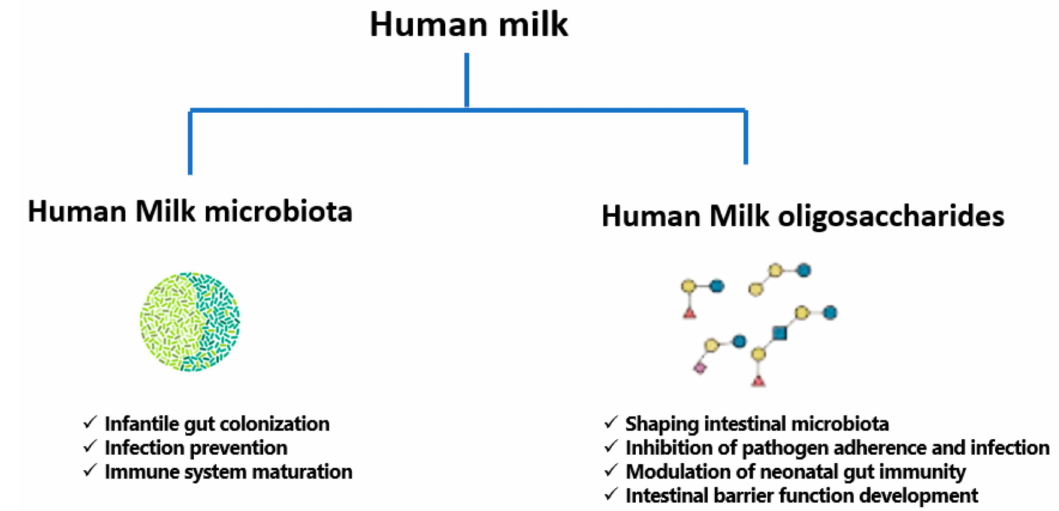
Figure 2. Functions of human milk microbiota and human milk oligosaccharides